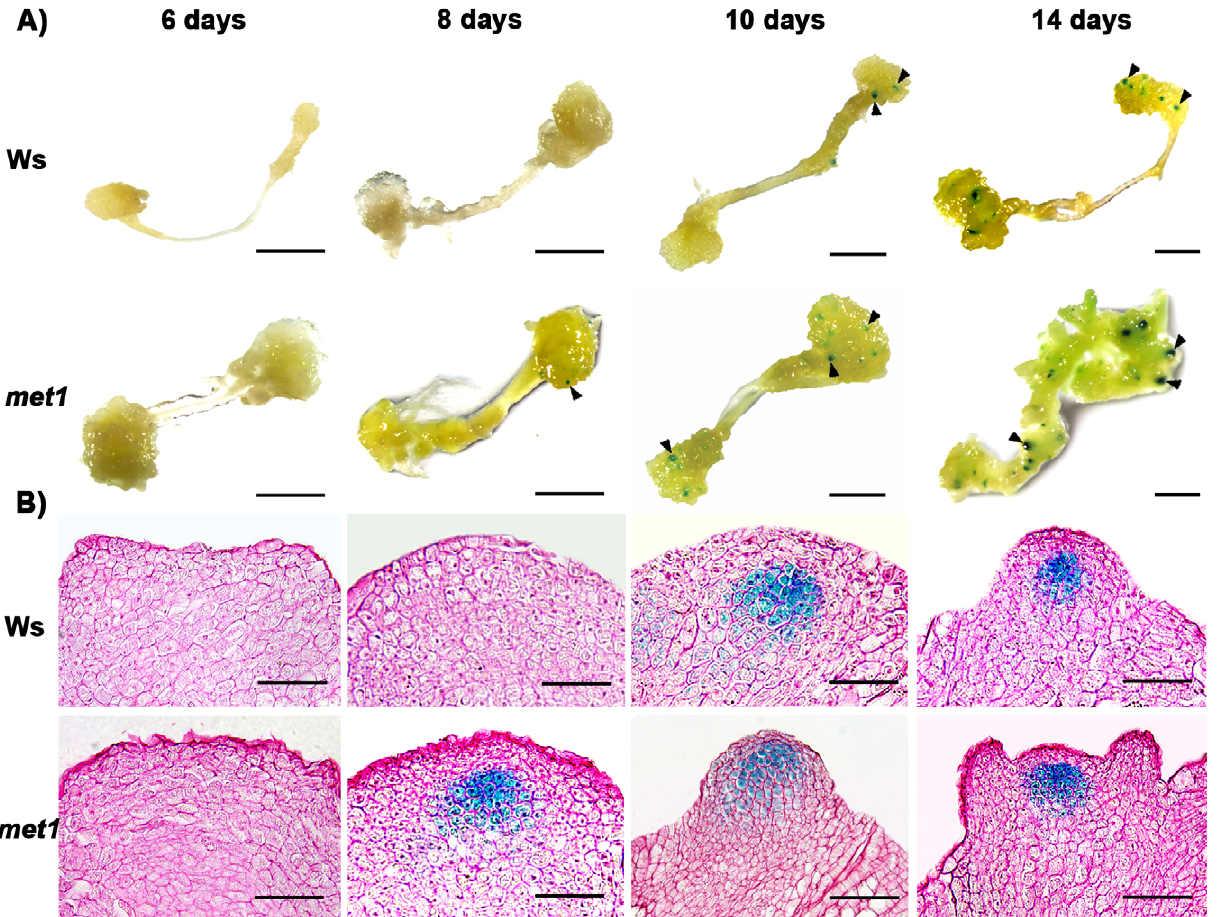
Figure 3. Regulation of WUS expression in met1 mutant. A) By roots as explants, pWUS::GUS transgenic calli in the wild type transferred onto SIM for 6 days, 8 days, 10 days and 14 days, and pWUS::GUS transgenic calli in the met1 mutant transferred onto SIM for 6 days, 8 days, 10 days and 14 days. Arrowheads indicate pWUS::GUS signals. Scale bars, 1 mm. B) Longitudinal sections of pWUS::GUS transgenic calli in both the wild type and the met1 mutant transferred onto SIM for 6 days, 8 days, 10 days and 14 days, respectively. Scale bars, 50 m m.